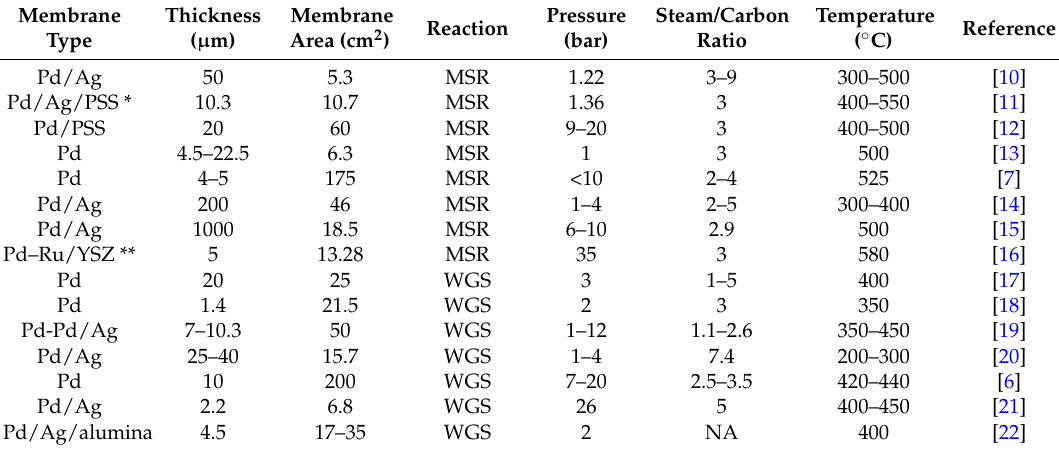
Table 1. Palladium-based catalytic membrane reactors used for methane steam reforming (MSR) and water gas shift (WGS)